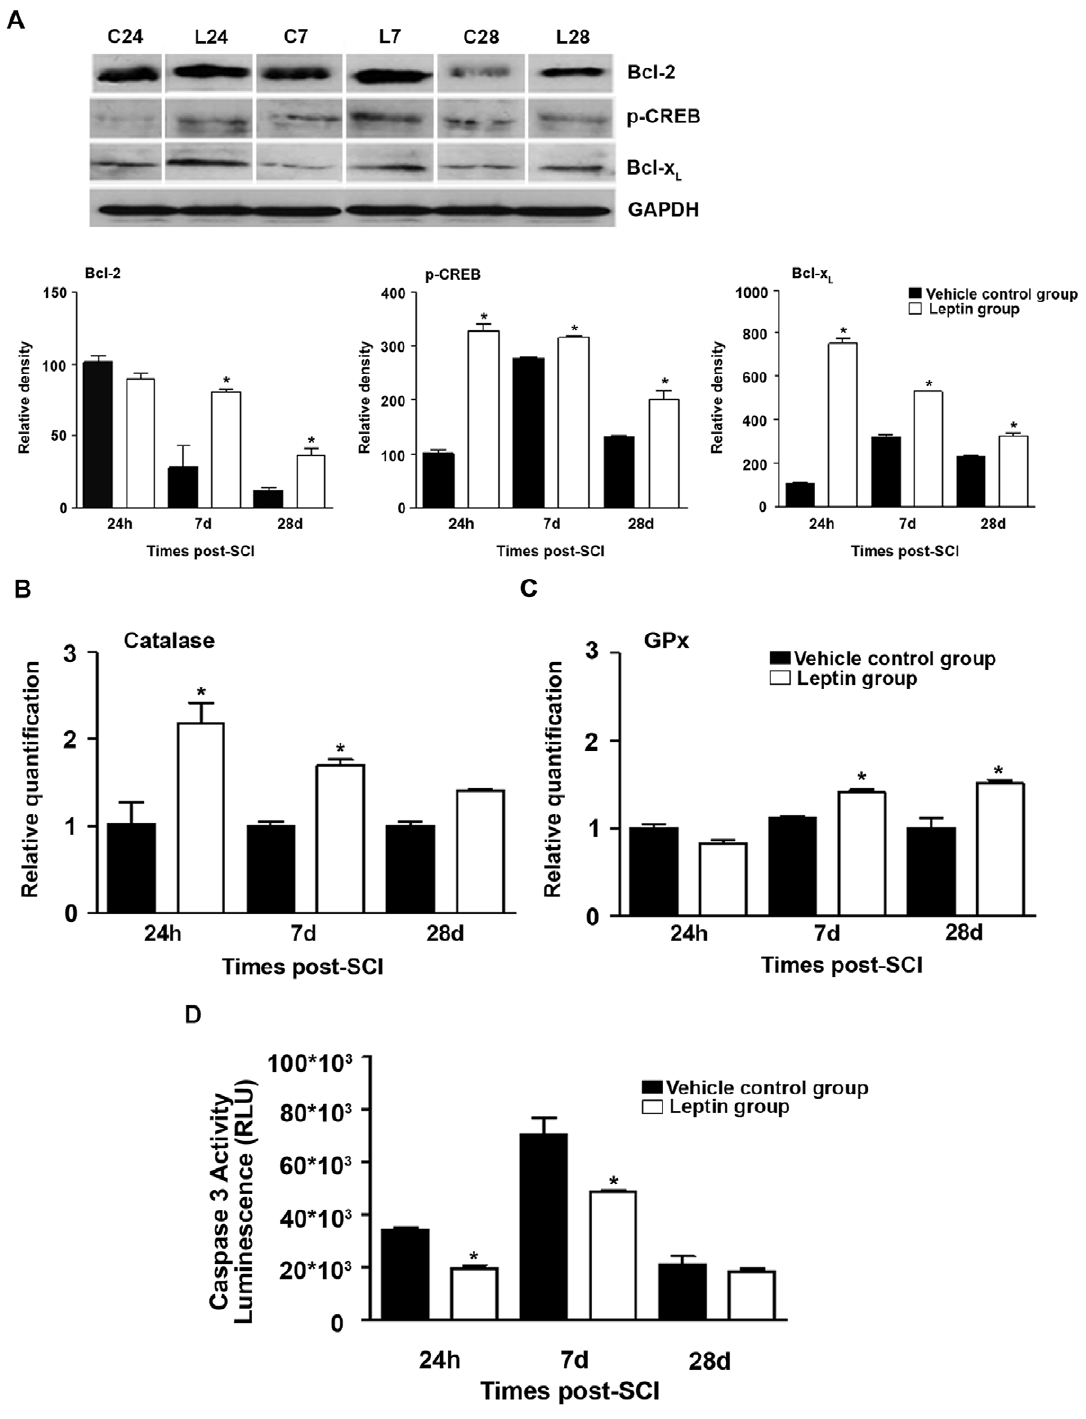
Figure 3. Leptin administration increased the expression of neuroprotective genes. (A) Leptin treatment induced an increase in Bcl-2, Bcl- x L and p-CREB proteins when compared with vehicle-treated controls. Bcl-2 protein levels were increased significantly beginning at 7 d post-SCI and remained elevated until 28 d post-SCI. Bcl-x L and p-CREB protein levels were increased significantly beginning at 24 h post-SCI and remained elevated until 28 d post-SCI when compared with vehicle-treated controls. (B and C) An increase in antioxidant enzyme mRNA expression was observed in leptin-treated animals when compared with vehicle treated controls. In leptin-treated animals, catalase gene expression (B) was significantly increased after 24 h and remained elevated until 28 d post-SCI. GPx gene expression (C) was significantly increased after 7 d and remained elevated until 28 d after injury. (D) In the early stages after injury (24 h and 7 d post-SCI), leptin treatment decreased caspase-3 activity, while at later stages (28 d post-SCI) no differences were detected when compared with vehicle-treated controls. The white lines in the western blot analysis (A) represent the lanes that were run on the same gel but were non-contiguous. The data in (A) are presented as a percentage of the corresponding value in the vehicle-treated control group 24 h post-SCI. The values in A–D represent the mean 6 SEM; * p , 0.05 versus the vehicle control group. doi:10.1371/journal.pone.0035594.g003 PLoS ONE |